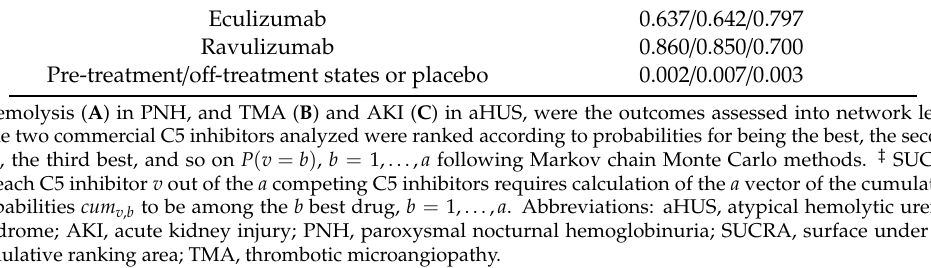
Table 3. SUCRA-based ranking of C5 inhibitors evaluated (clinical trials). Drug Intervention † C5 Inhibitors